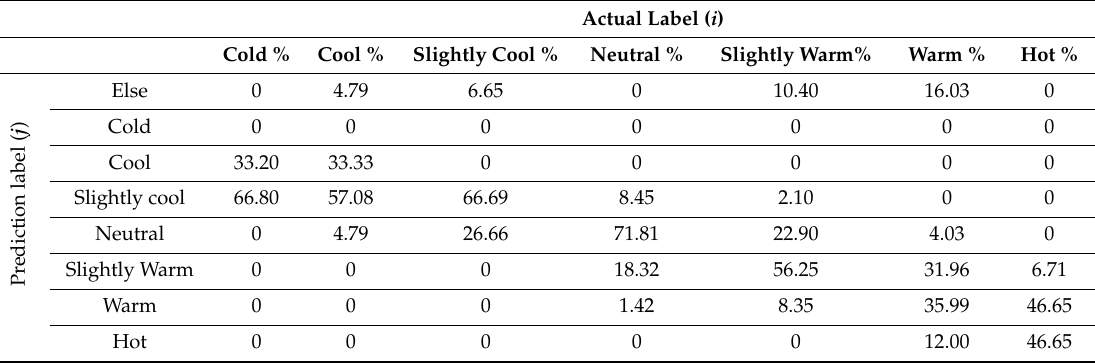
Figure 6. Error performance of the developed general classification model with the selected 12 input features (reduced dimension input space) for 7-classes classification problem. Table 5. The normalized confusion matrix of Model II.